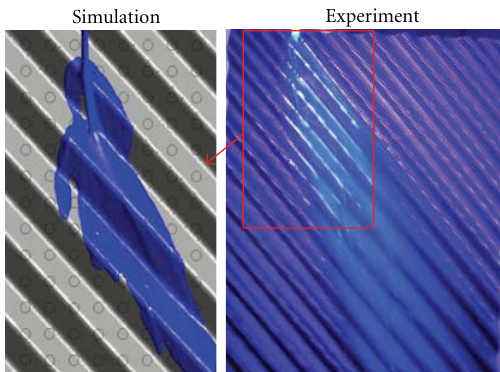
Figure 10: Comparison between simulation and experiment for flow of silicon-oil (DC5) on corrugated sheet of packing without holes. Flow rate: